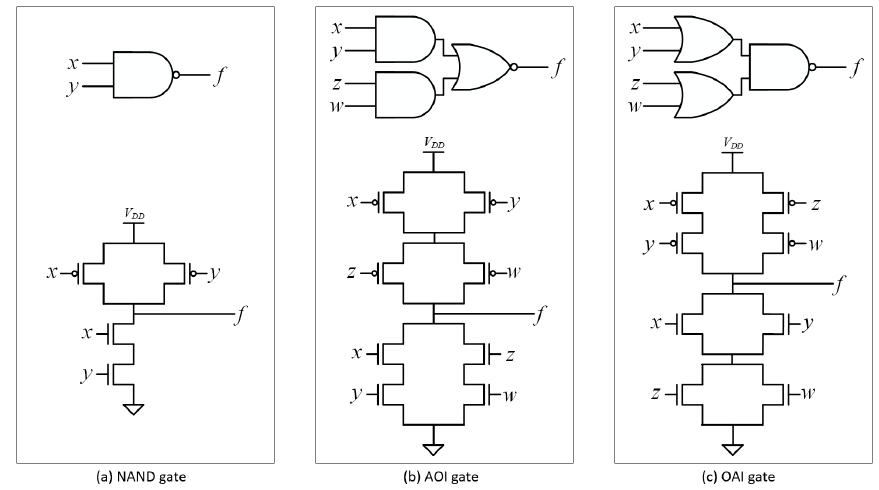
Figure 6. An efficient compound implementation of AOI gate and OAI